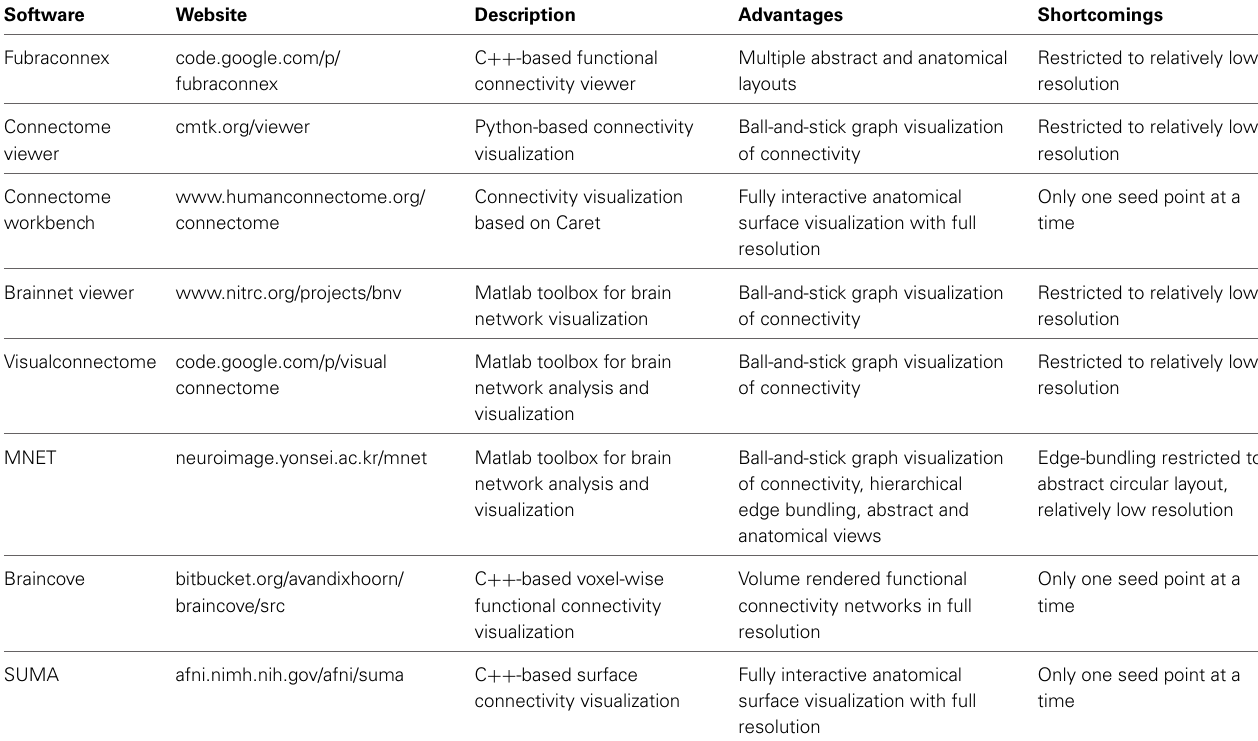
Table 1 | Overview of software for connexel visualization.